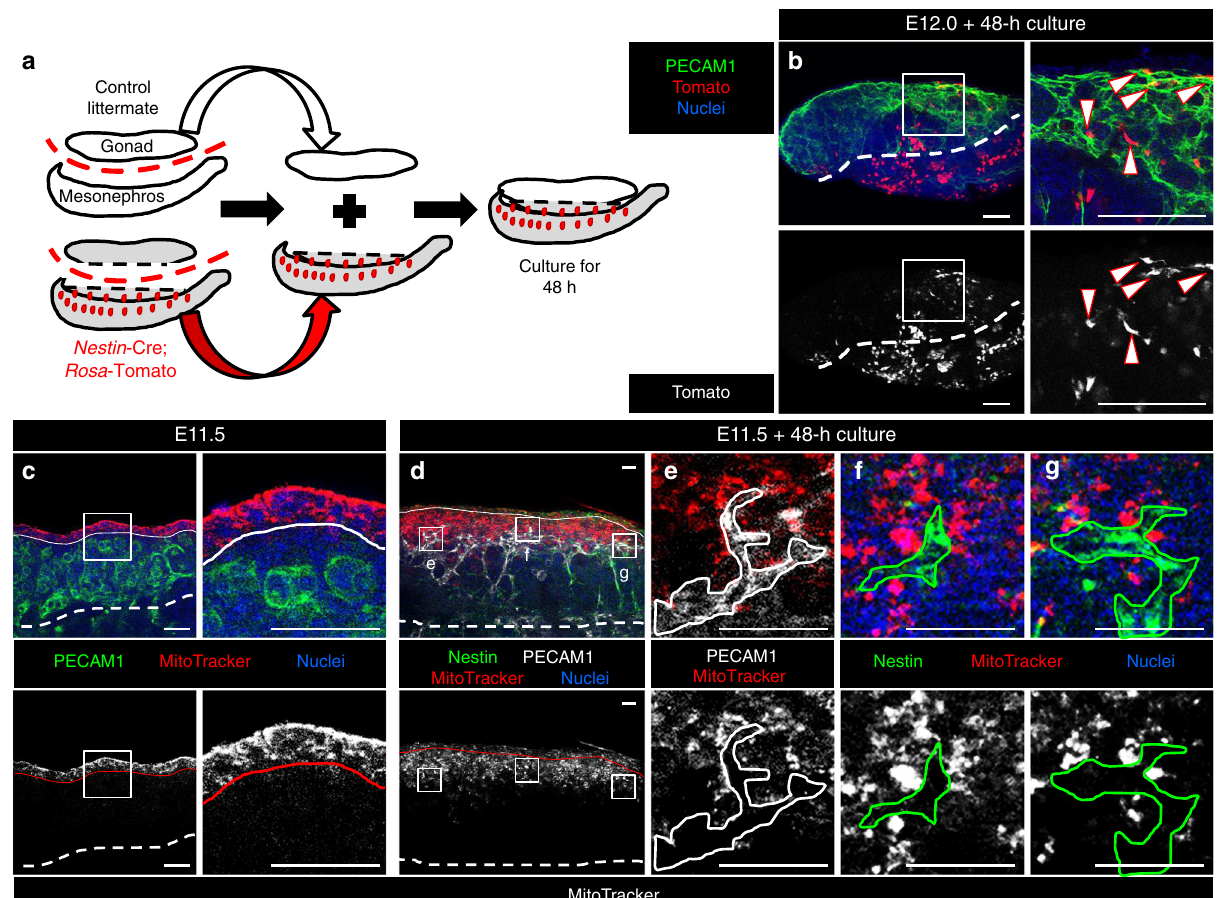
Fig. 3 Nestin-positive mesonephric cells migrate into the gonad. a Schematic of a gonad – mesonephros recombination culture assay, in which control gonads are cultured adjacent to Nestin -Cre; Rosa -Tomato mesonephroi. b – d Immuno fl uorescence images of recombination culture ( b ) and MitoTracker- labeled gonads ( c – g ). b Tomato-positive cells (arrowheads) are observed in gonads after recombination culture for 48 h. The dashed line in ( b ) indicates the border between gonad and mesonephric components. c E11.5 gonad immediately after incubation with MitoTracker, showing that only the coelomic epithelium (above the solid line in ( c )) was initially labeled. d After 48 h culture, MitoTracker label was observed below the coelomic epithelium (solid line in ( d )) and deeper within the gonad. MitoTracker label was not observed within PECAM1-positive endothelial cells (white outline in ( e )) nor within Nestin- positive cells (green outlines in ( f , g )). Dashed lines in ( c , d ) indicate gonad – mesonephros border. Scale bars, 50 μ